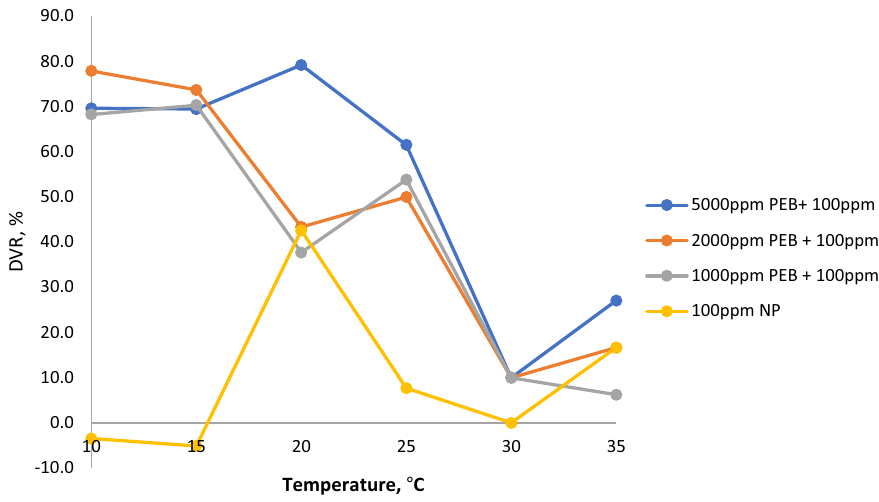
Fig. 8 Comparison of the degree of viscosity reduction (DVR) of different concentra- tion of polymer/nanoparticle blend at varying